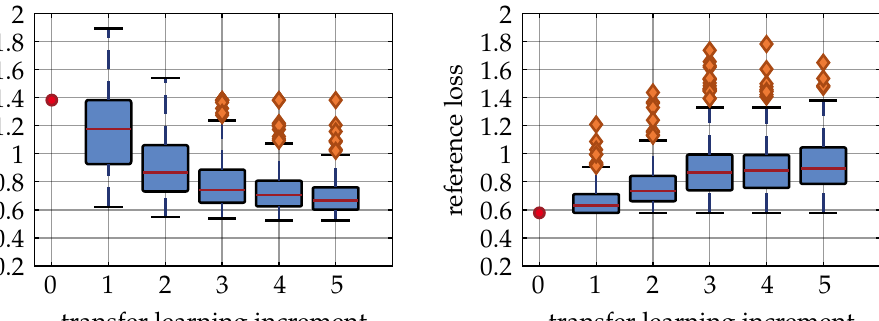
Figure 10. Training results for driver 3 (dynamic).